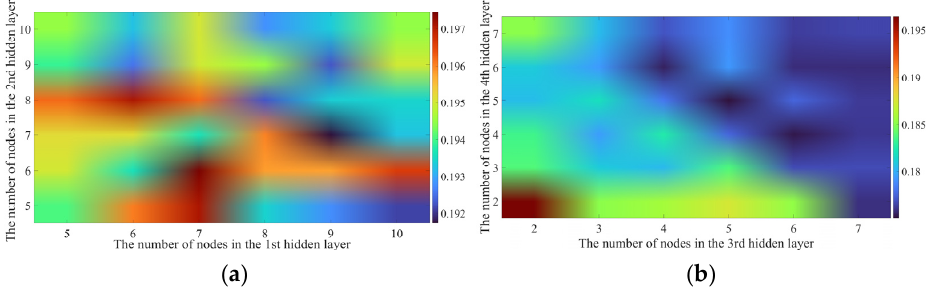
Figure 10. Changes of training accuracy under different number of nodes in the (a) 1st and 2nd hidden layer, (b) 3rd and 4th hidden layer.